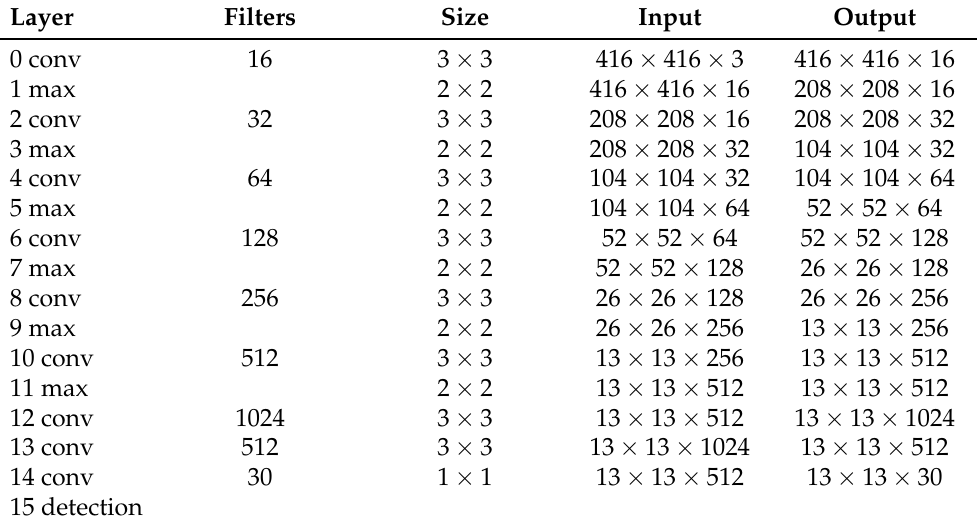
Table A3. Tiny YOLOv2 Architecture.